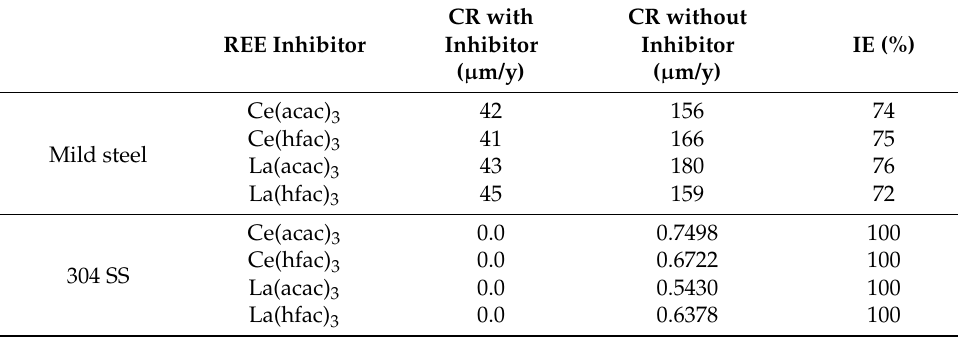
, and La ( hfac ) inhibitors in 3.5% NaCl 3 3